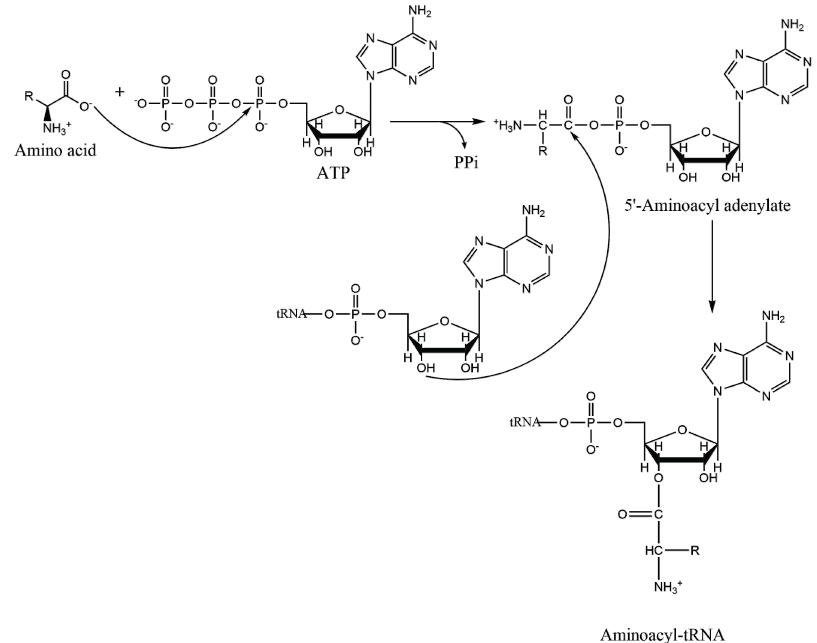
Figure 4. Catalytic mechanism of aminoacylation by aminoacyl-tRNA synthetases. The top row represents the first step in which an aminoacyl adenylate intermediate is formed. In the second step, the “charged” aminoacyl-tRNA is formed. Binding of cognate tRNA is required for adenylate formation for GluRS, GlnRS, ArgRS, and LysRS-1 enzymes. Class II AARSs catalyze nucleophilic attack on the adenylate using the A76 3 ʹ -hydroxyl; class I enzymes use the 2 ʹ -OH for initial attack before transesterification to the 3 ʹ